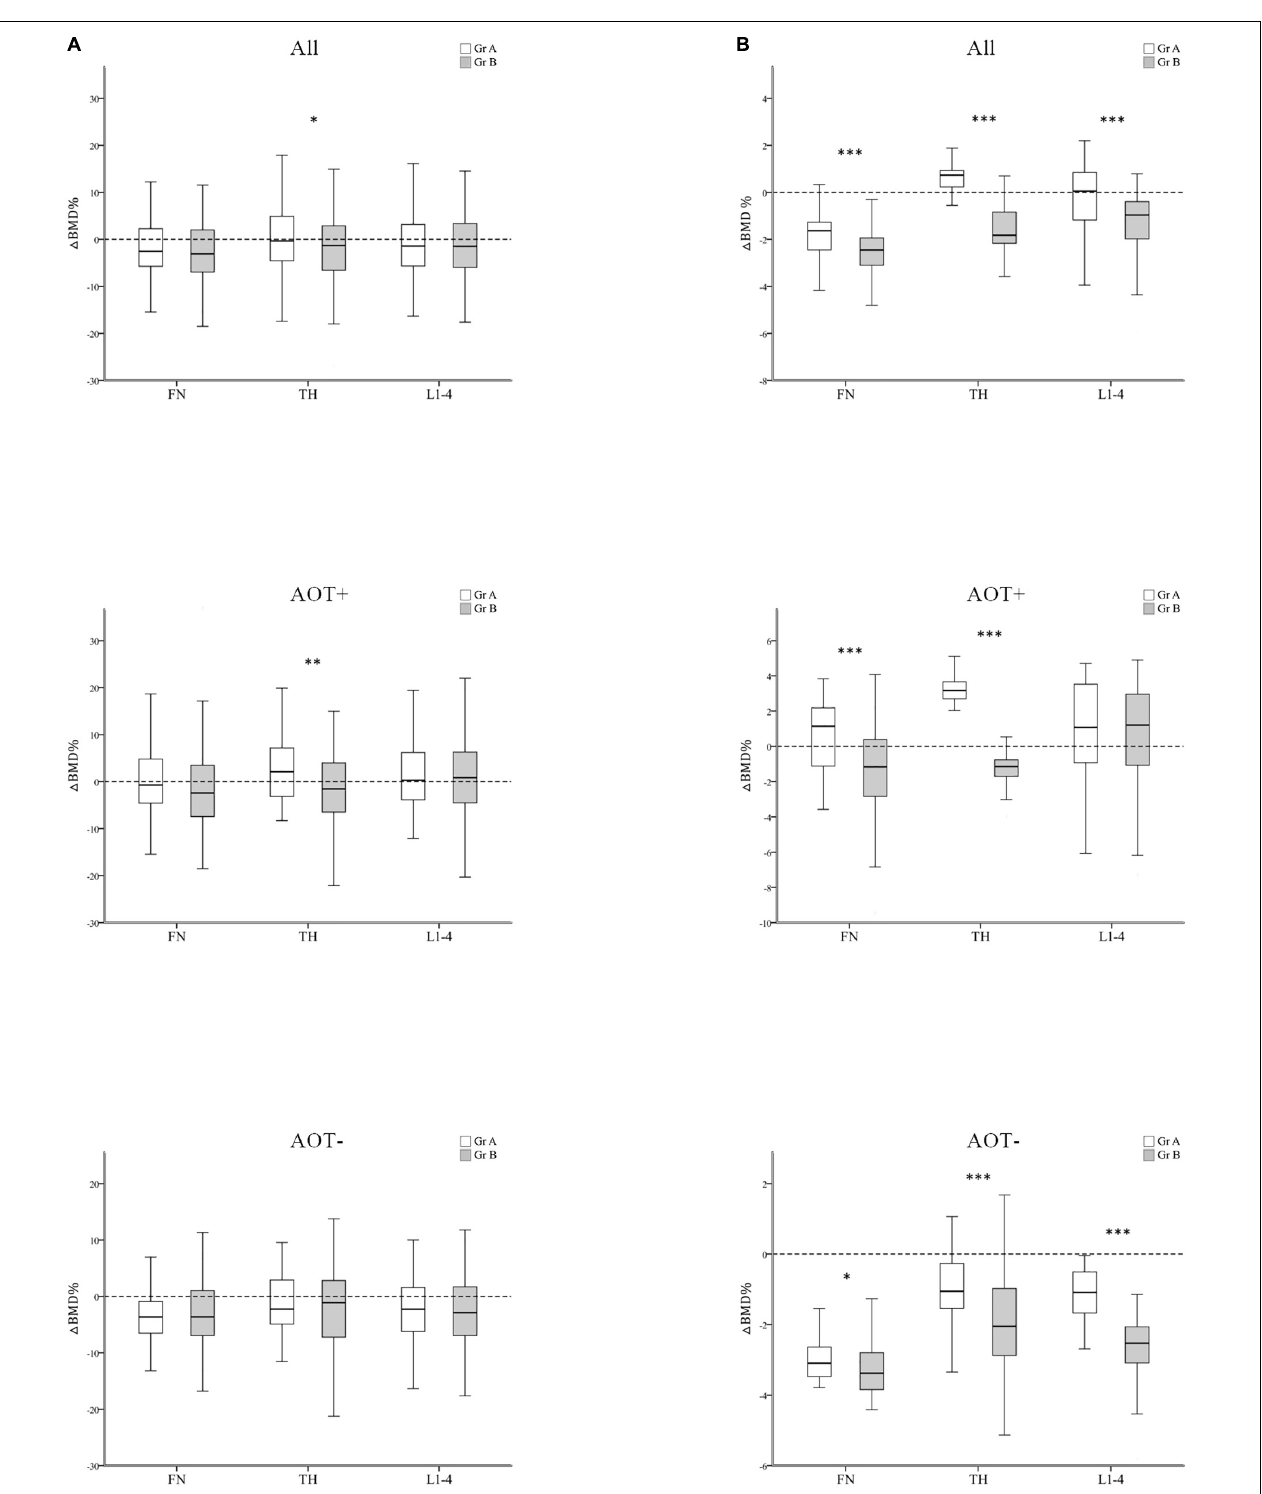
FIGURE 3 | Regression-adjusted percentage change in BMD ( (cid:49) BMD%) between group A and group B, after matching in all participants and participants with or without anti-osteoporotic therapy (AOT). Unadjusted (A) and regression-adjusted (B) percentage of change in BMD at the femoral neck (FN), total hip (TH), and first through fourth lumbar vertebra (L1–4) after 3 years in group A and group B, combined with AOT presence. Box-and-whisker plots showed the median, interquartile range, and extreme values. ∗ p < 0.05; ∗∗ p < 0.01; ∗∗∗ p < 0.005.